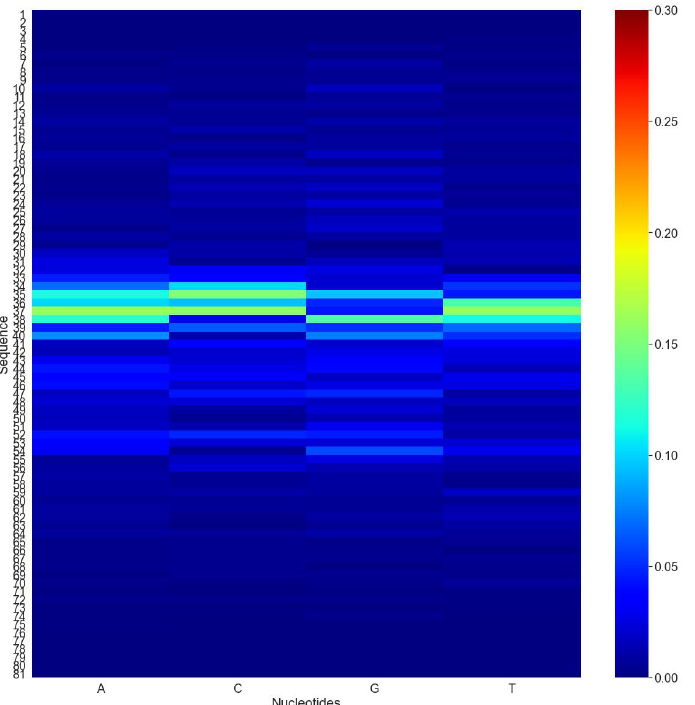
Figure 4. Computational mutation scanning was conducted for each promoter sequence in the test set to determine whether changing each base of the input subsequence affected. Red indicates a high frequency of mutations, while blue indicates a low frequency of mutations.